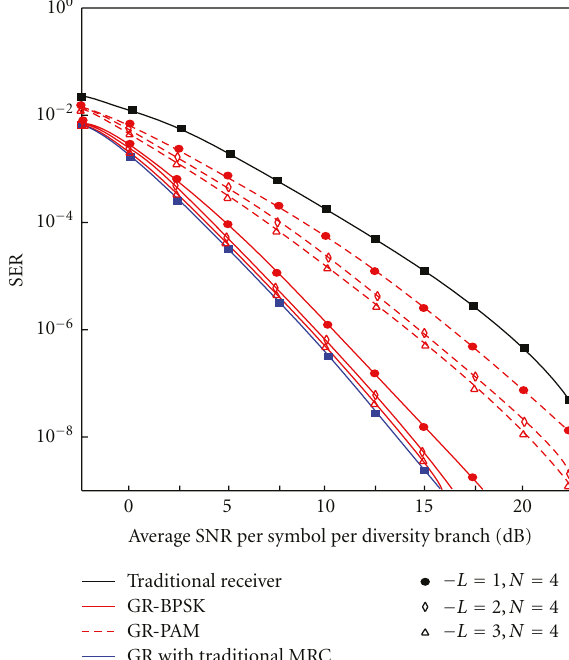
Figure 3: Average SER of coherent BPSK and 8-PAM for GR with quadrature subbranch HS/MRC and HS/MRC schemes versus the average SNR per symbol per diversity for various values of 2 L with 2 N =